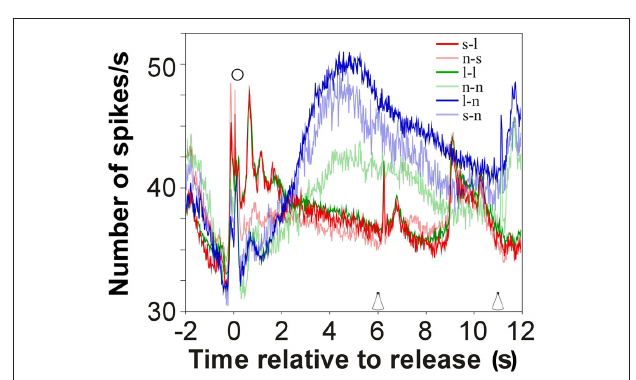
Figure 8 | grand average response in auditory cortex for six relationships between the reward in a trial and that in the preceding trial. Reward increases: red (small reward followed by large reward) and pale red (no reward followed by small reward); no reward changes: green (large reward followed by large reward) and pale green (no reward followed by no reward); reward decreases: blue (large reward followed by no reward) and pale blue (small reward followed by no reward). Symbols as in Figure 2